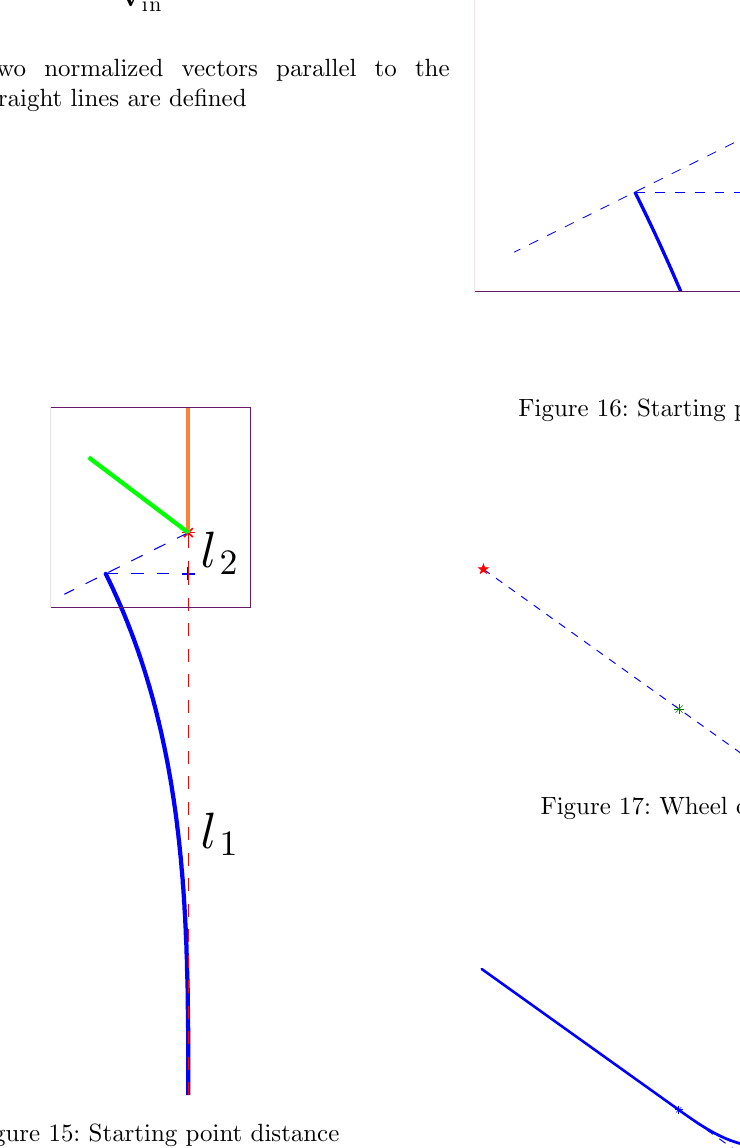
Figure 15: Starting point distance